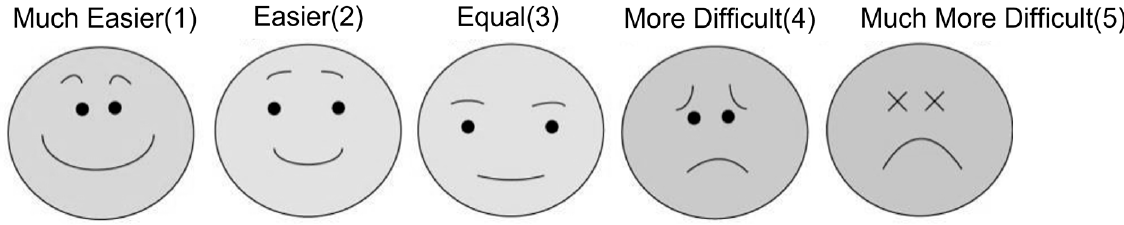
Figure 1. Face scale of the subjective difficulty of swallowing compared to thin